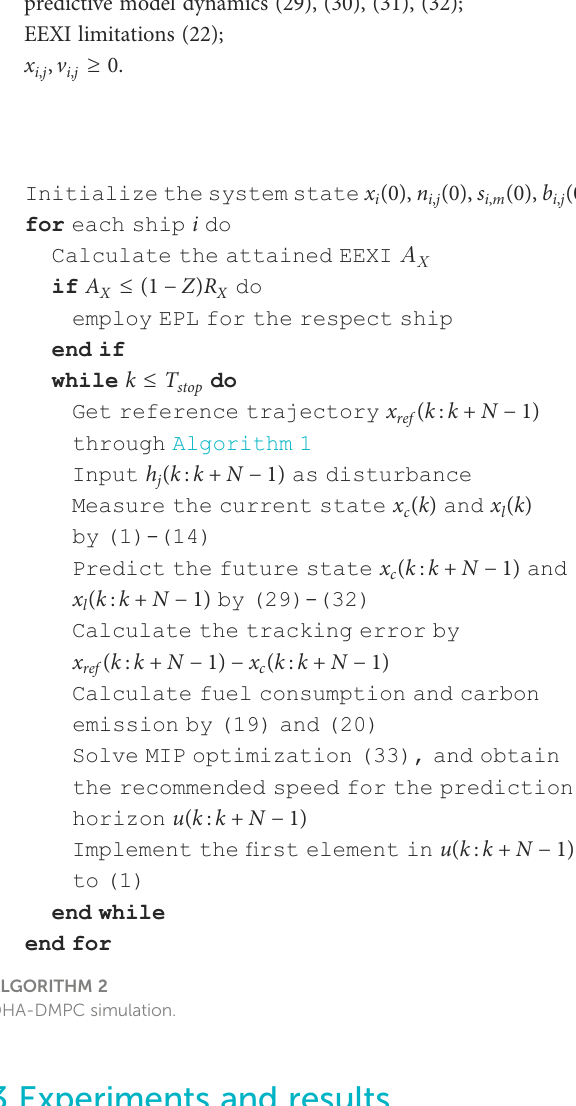
ALGORITHM 2 DHA-DMPC